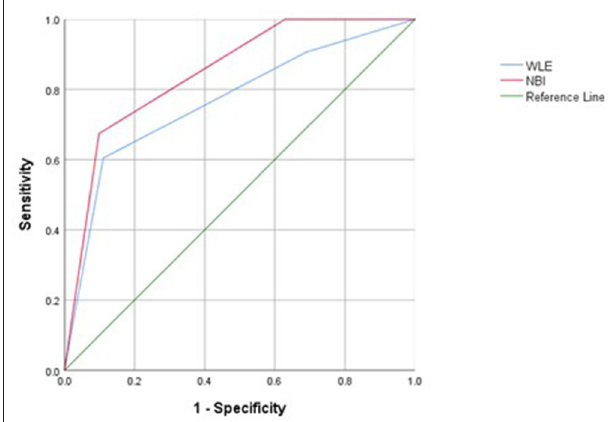
FIGURE 3 | Receiver operating characteristic (ROC) curves of histological healing (HH) assessed with white light endoscopy (WLE) and NBI in patients with UC.